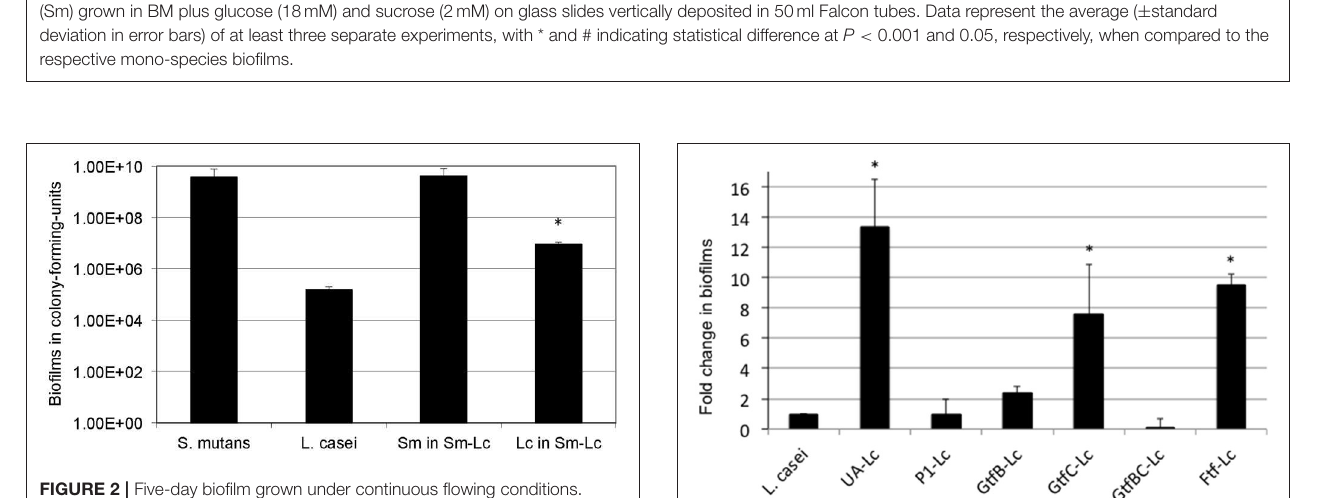
FIGURE 3 | L. casei biofilm formation with S. mutans mutants. L. casei (Lc) was grown alone or together with S. mutans wild-type UA159 (UA) and its mutants deficient of P1, GtfB, GtfC, GtfBC, or Ftf in biofilm medium with glucose and sucrose for 48-h. Data are expressed as the ratio of L. casei biofilms (in colony-forming-units) in dual-species over those in mono-species, with * indicating significant differences at P <